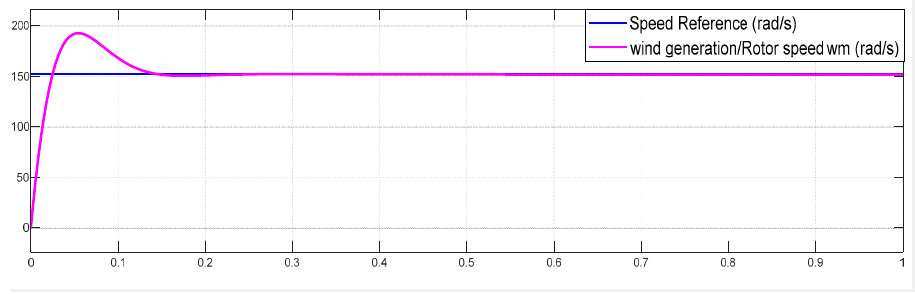
Figure 11. Speed tracking.